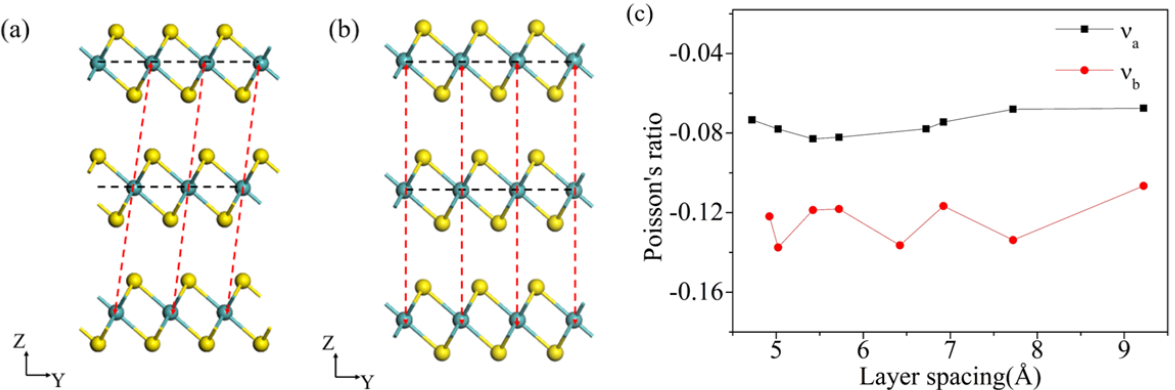
Figure 4. ( a ) The original structure of MoS 2 . ( b ) The structure with overlapping alignment between layers of MoS 2 . ( c ) The relationship between PR and layer spacing for two different arrangements of structures.